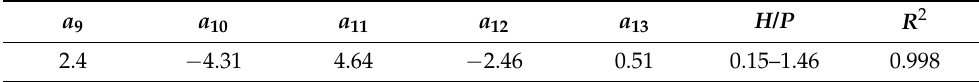
Table 3. Coefficients of corresponding fitting formulas.